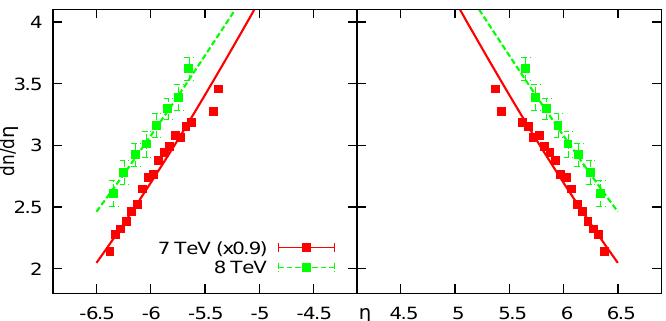
Figure 1. Charged particle dN distributions from the LHC TOTEM experiment, fitted with the result d η of the relativistic hydro solution described in this